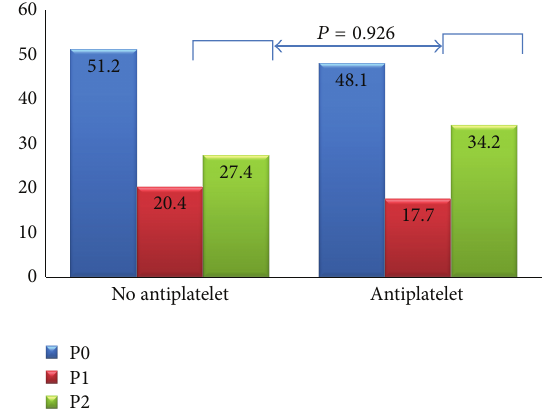
Figure 2: Prevalence (%) of SBCE bleeding lesions with and without antiplatelet